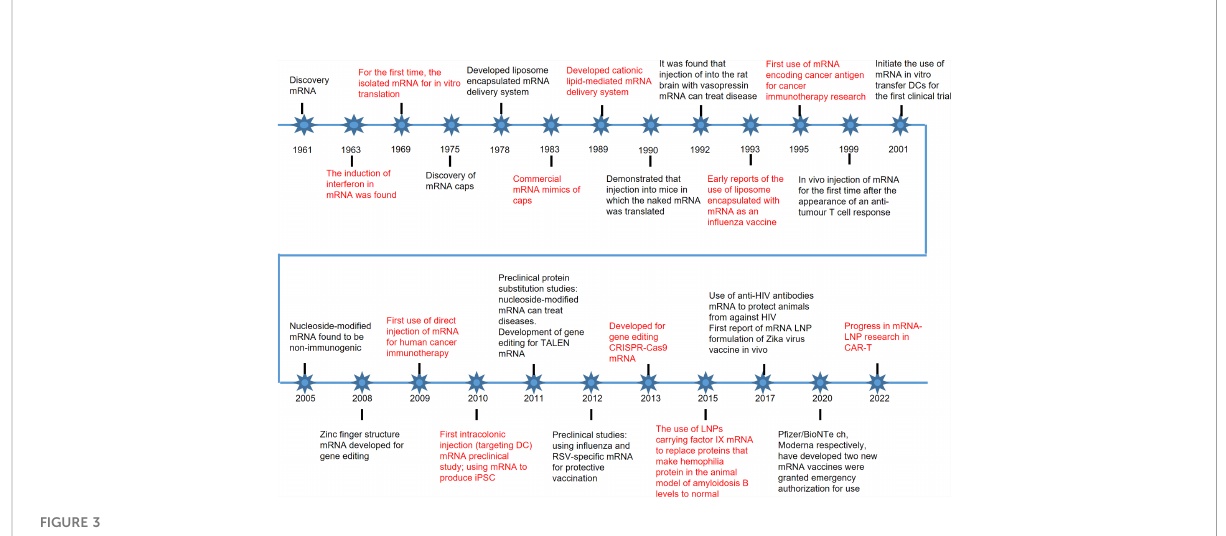
FIGURE 3 History of mRNA